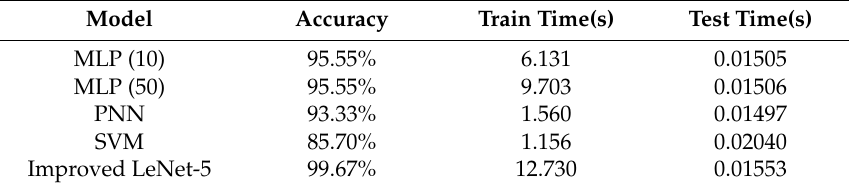
Table 6. Comparison of performances with shallow models. Table 9. Comparison of performances with shallow models.